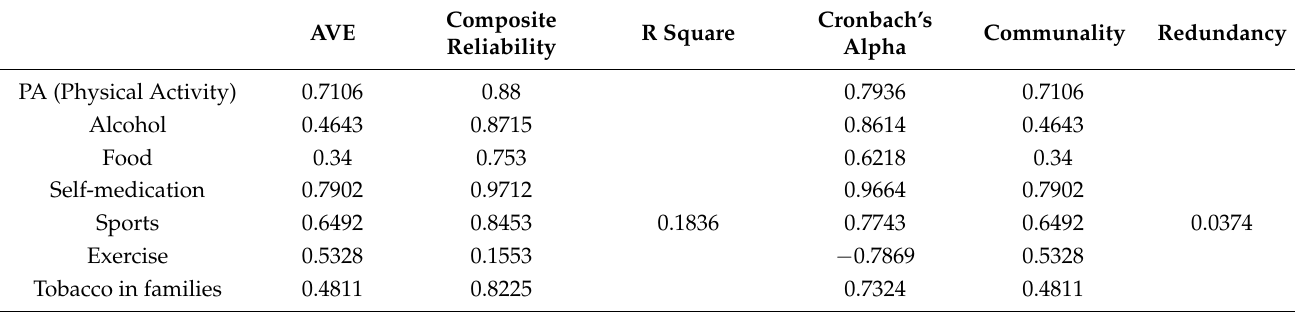
Table 2. The reliability of the measuring tool.